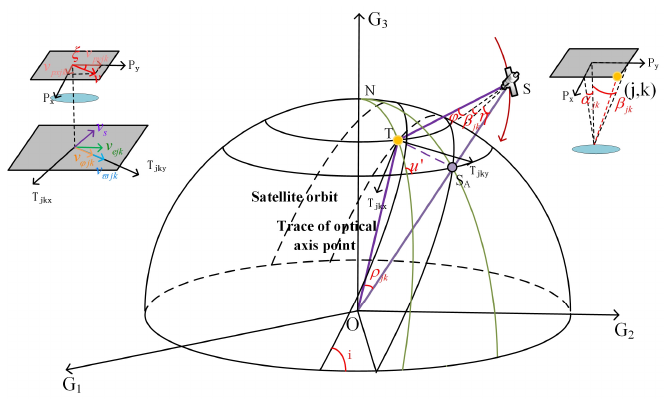
Figure 3. Establishment of velocity vector.